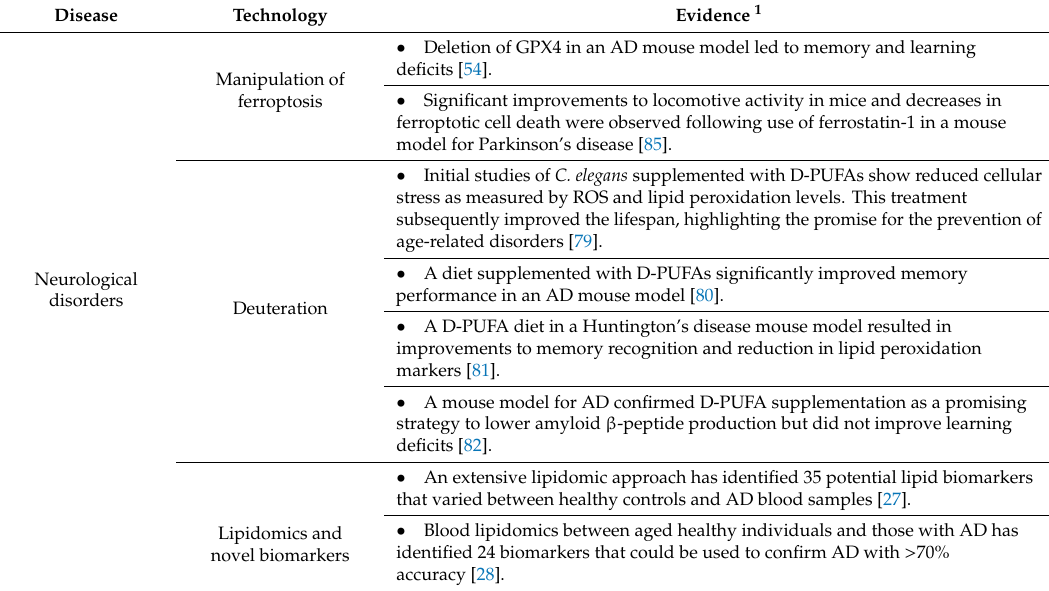
Table 1. Summary of current lipid-based strategies to combat